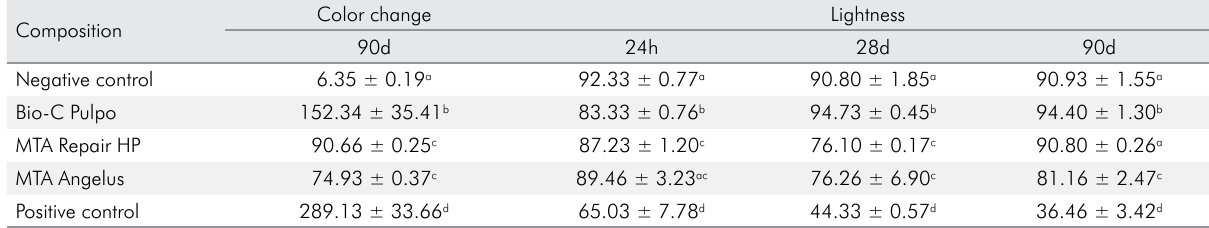
Table 1. Representation of mean and standard deviation values of color change ( Δ E) after 90 days, and lightness (L) at 24 hours, 28, and 90 days of